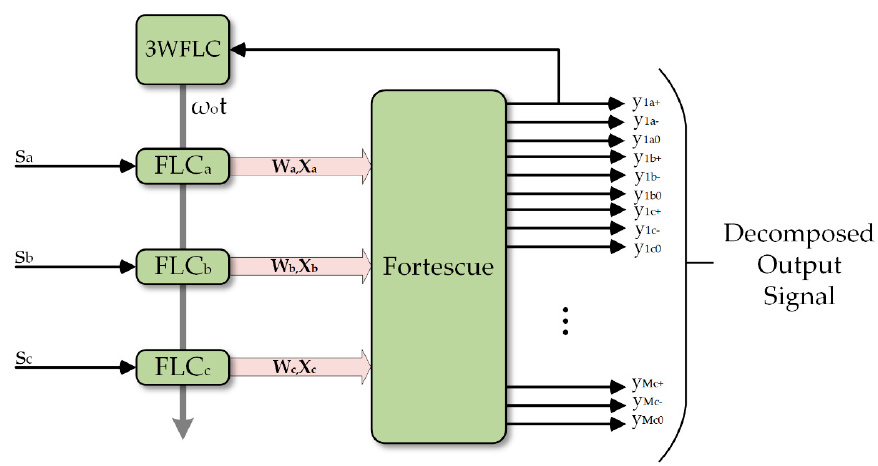
Figure 2. Sequence Detector Fourier Linear Combiner (SDFLC) and Three-phase Weighted-frequency Fourier Linear Combiner (3WFLC) implementation.